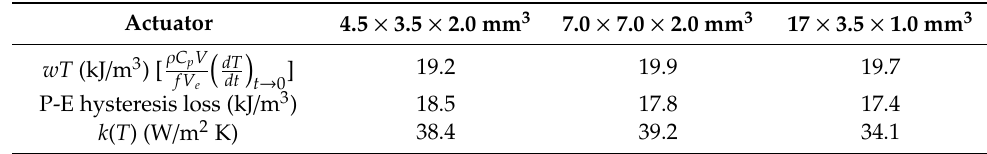
Figure 15. Overall heat transfer coefficient, k(T), plotted as a function of applied electric field ( a ), and of frequency ( b ) for a PZT ML actuator with 7 × 7 × 2 mm 3 driven at 400 Hz. Table 3. Loss and overall heat transfer coefficient for PZT multilayer samples (under E = 3 kV/mm, f = 300 Hz) [34].